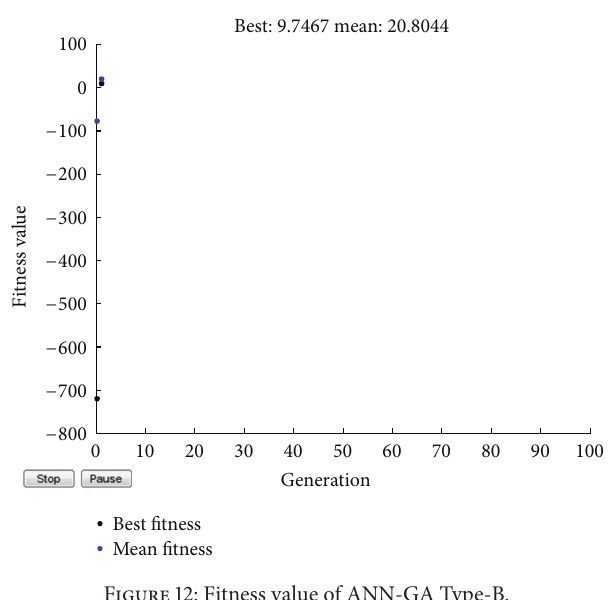
Figure 11: Fitness value of ANN-GA Type-A.